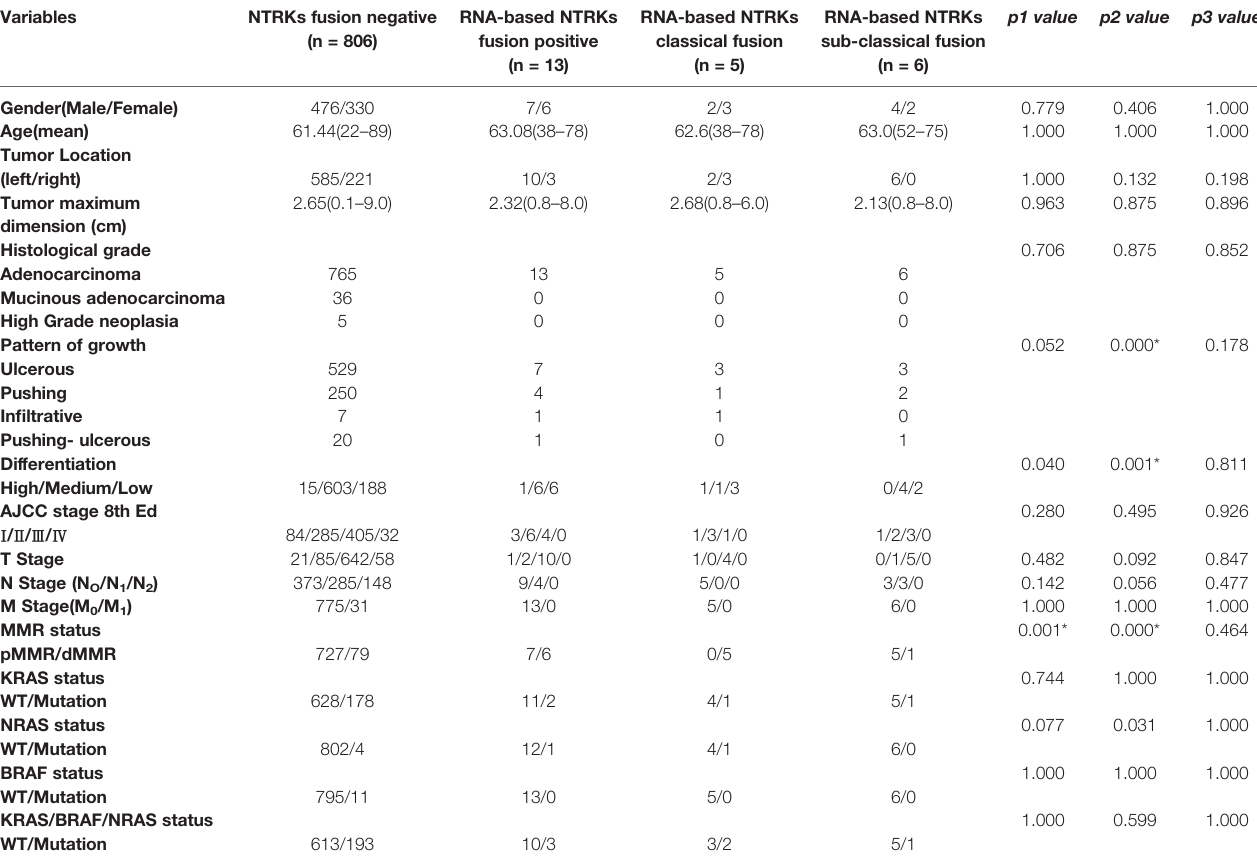
TABLE 2 | Cliniopathological characteristic of NTRK fusion-negative (n = 806) and different NTRK fusion-positive CRCs.